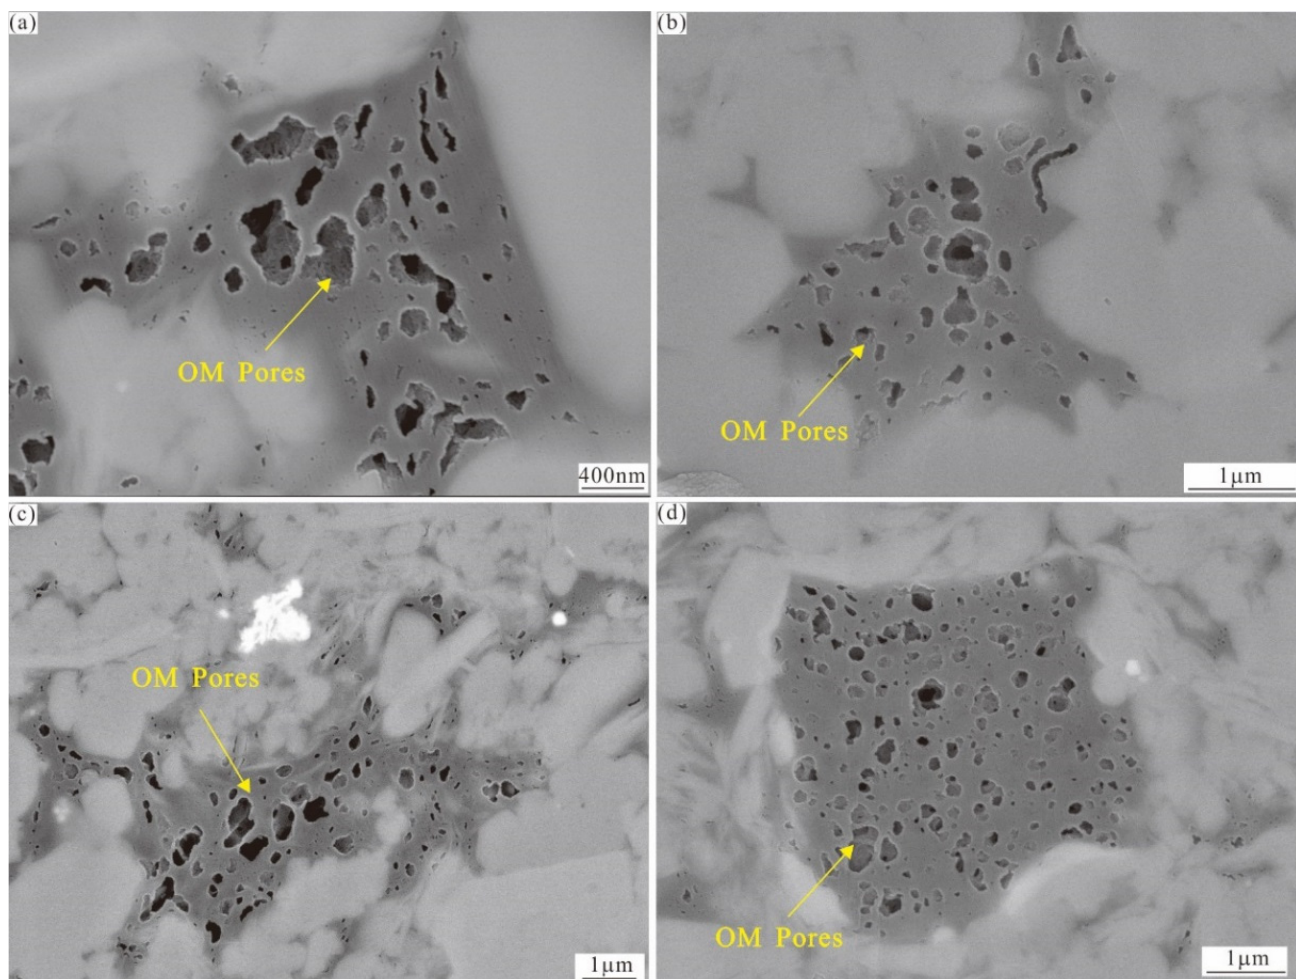
Figure 4. SEM images showing pore types of the Silurian Longmaxi marine shale. ( a ) Gray–black siliceous shale, TOC = 3.69%; ( b ) gray–black carbonaceous shale, TOC = 3.29%; ( c ) gray–black carbonaceous shale, TOC = 2.94%; ( d ) gray–black siliceous shale, TOC = 3.81%.